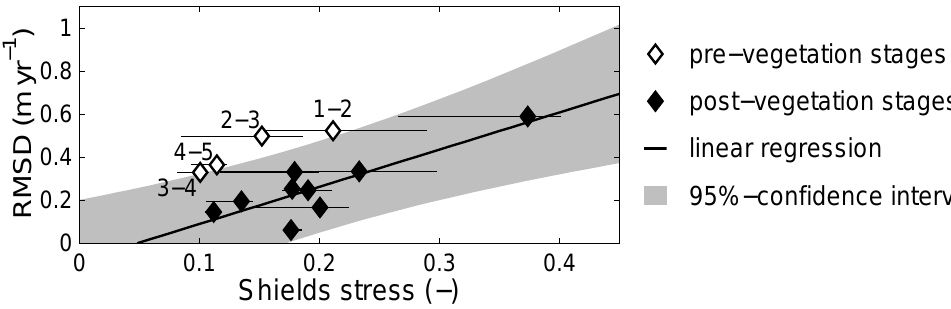
Figure 11. Linear regression between time-averaged Shields stress (–) and the root-mean-square elevation difference (RMSD, myear − 1 ) for the study area as a whole. The open and filled markers correspond to the pre-vegetation and post-vegetation stages, respectively. The solid black line denotes the linear regression curve for the period after riparian vegetation emerged (between surveys 5 and 14). The grey-shaded area indicates the extent of the 95% confidence interval of the regression model. The extent of the black horizontal lines indicate the 25% and 75%